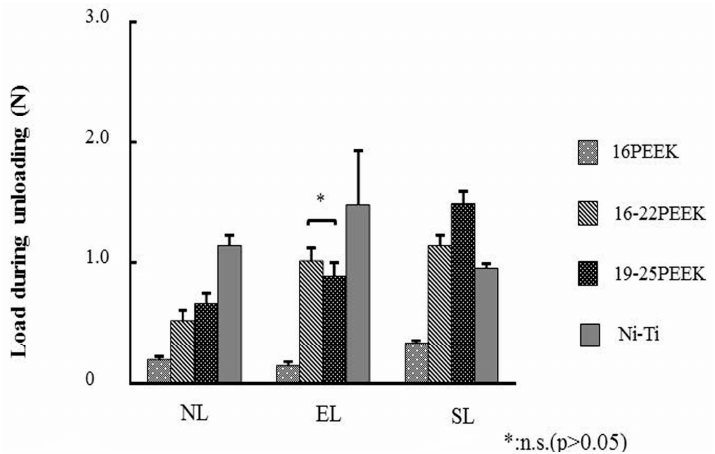
Figure 3. Load values of each wire at a deflection of 1500 µ m during unloading for the respective ligation